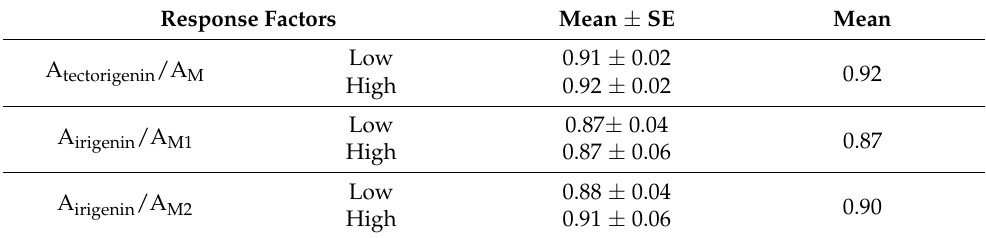
Table 1. Response factors of glucuronidation metabolites to tectorigenin and irigenin ( n = 3).